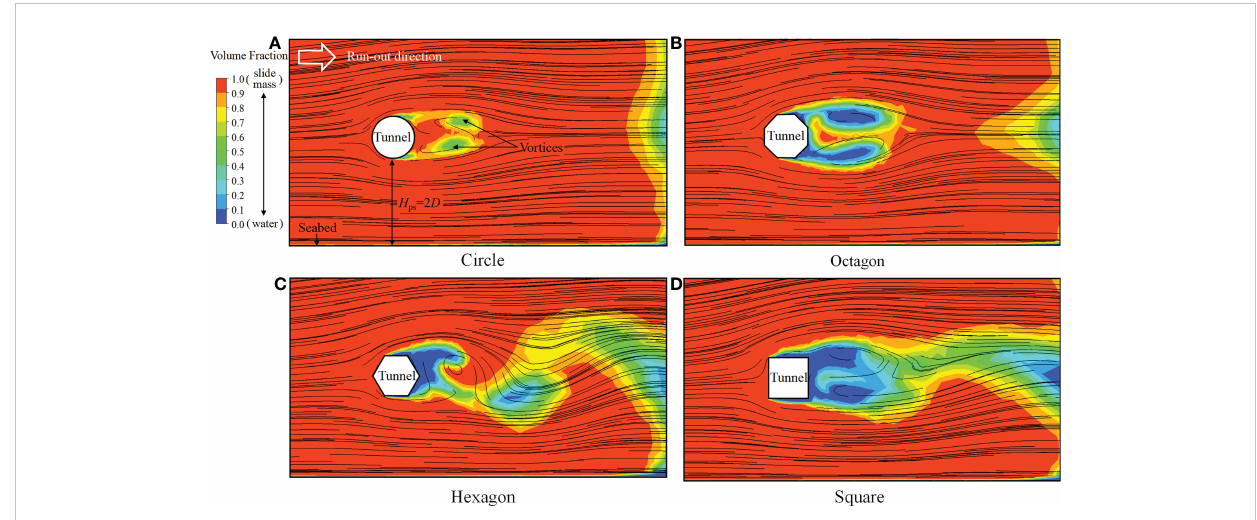
FIGURE 9 Flow velocity fi eld comparison between the circular and polygonal cross-section tunnels under the impact of submarine slides: circle (A) , octagon (B) , hexagon (C) , and square (D)